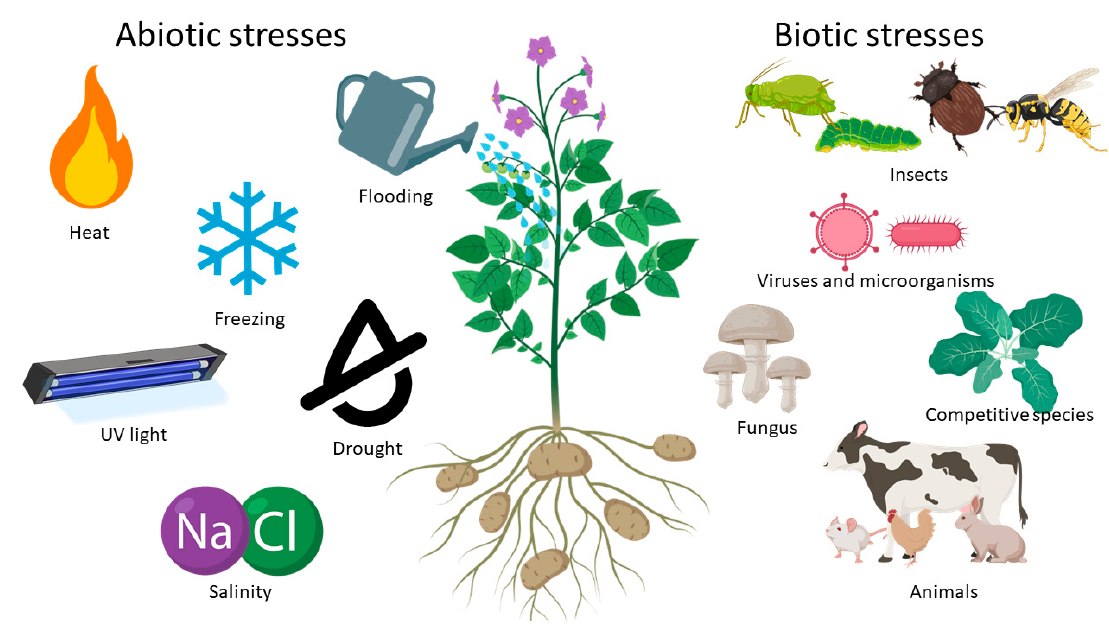
Figure 4. Different types of biotic and abiotic stresses that can affect plants. Figure 4. Di ff erent types of biotic and abiotic stresses that can a ff ect